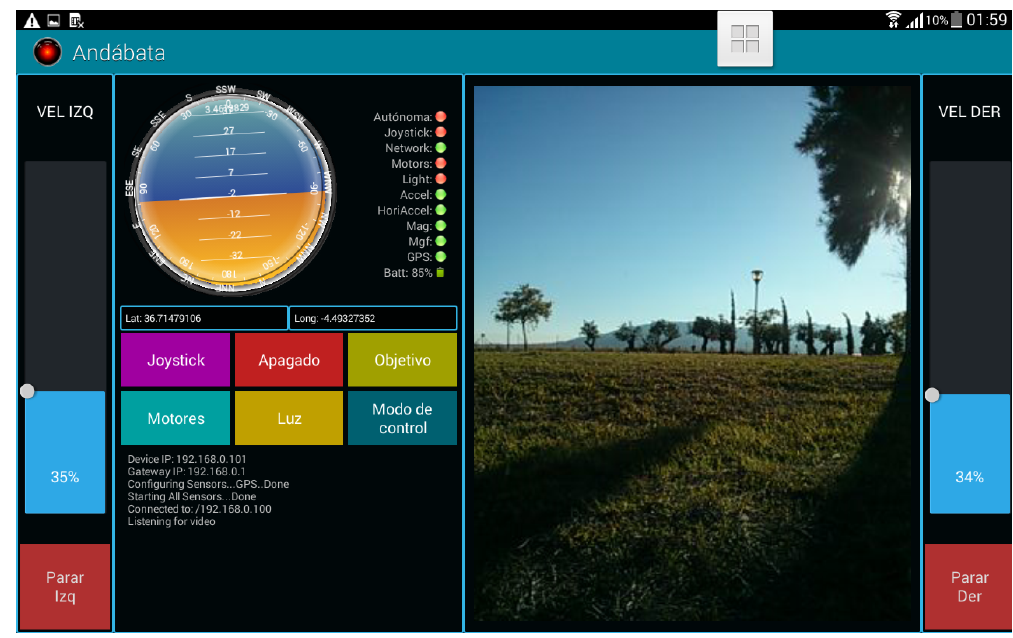
Figure 3. User interface of the Android app Andabata on the tablet.